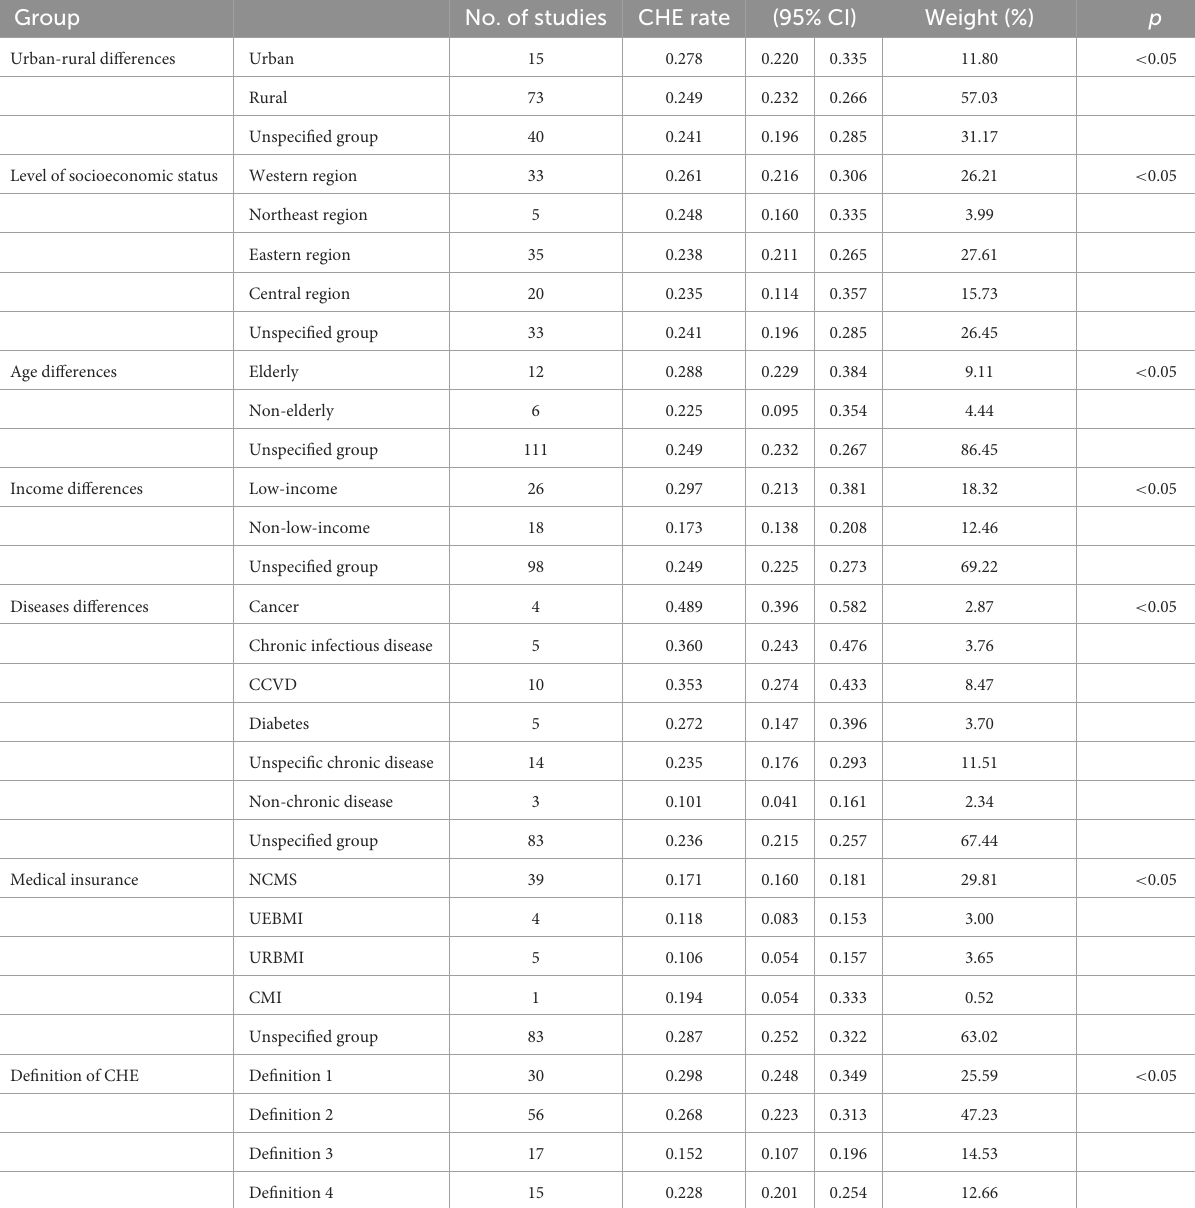
TABLE 2 Subgroup analysis of the rate of catastrophic health expenditures.